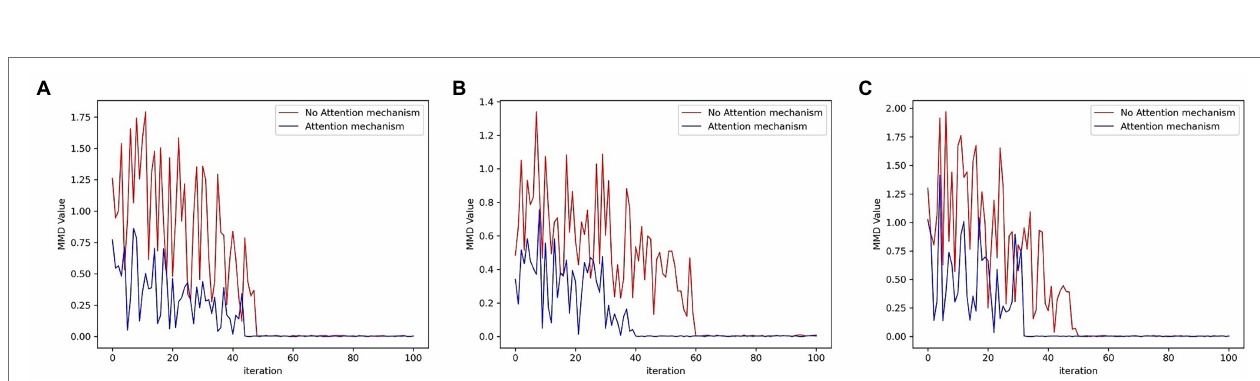
FIGURE 9 | MMD values for each data set (A) SWMRU; (B) KDDCUP99; (C)